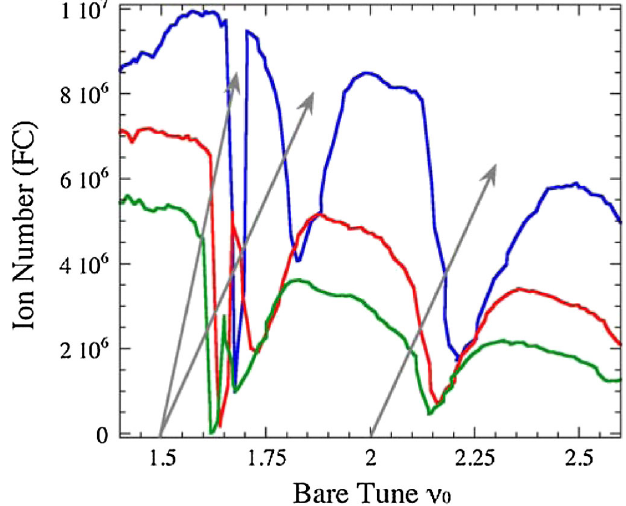
FIG. 9. (Color) Experimental results obtained under three differ- ent initial conditions (colors) of Ar þ plasmas. The current of the electron beam for ionization and/or the neutral gas pressure is changed to control the initial plasma density. The amplitude of the N sp ¼ 3 wave is 0.5% of the primary-wave amplitude. The plasma storage time is 1 msec.